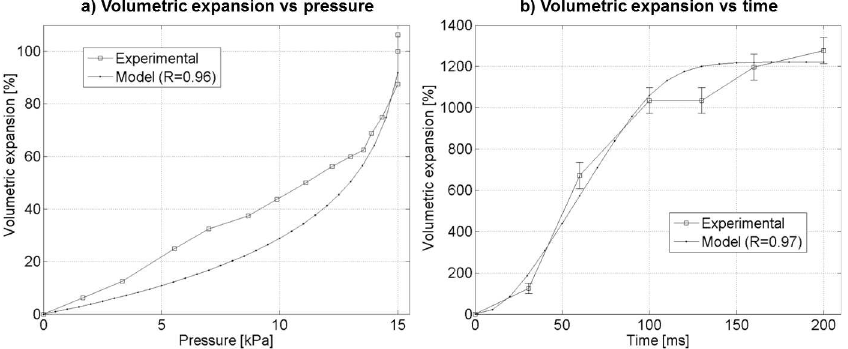
Fig 3. Volumetric Response of Modules. a) Volumetric expansionvs pressure. b) Instantaneous volumetric expansionresponseto a 138 kPa pressureimpulseshowinga rapid expansionof the module.Models describedon Eqs 1 and 2 are fitted to the